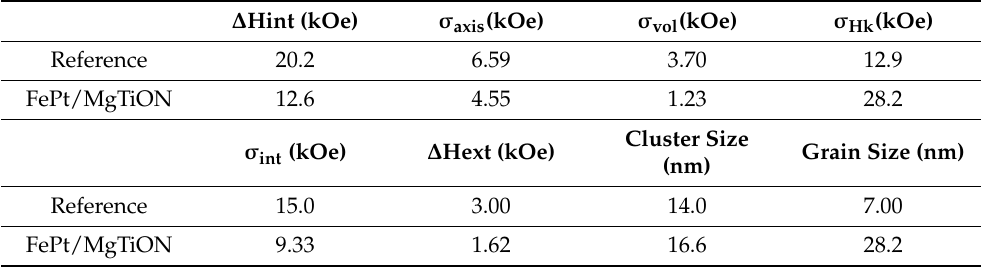
Table 1. Magnetic switching field behavior of the FePt(B, Ag, C) granular film and the reference sample